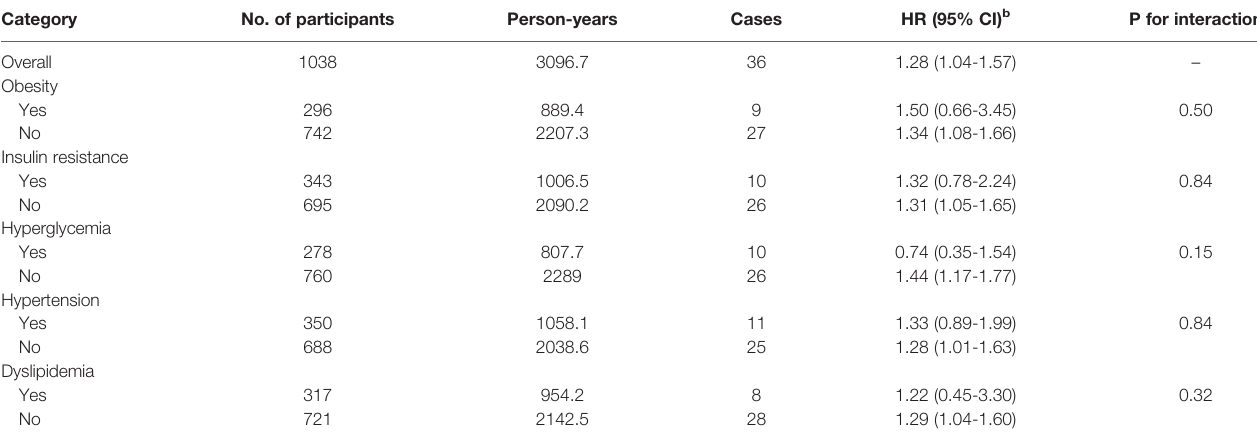
TABLE 2 | Associations of each 10-unit increase in the 21-gene RS with breast cancer recurrence by metabolic risk factors a . Category